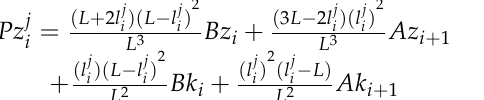
Figure 12. Spatial curve extension algorithm: ( a ) edge data extension and ( b ) data extension outside the boundary.